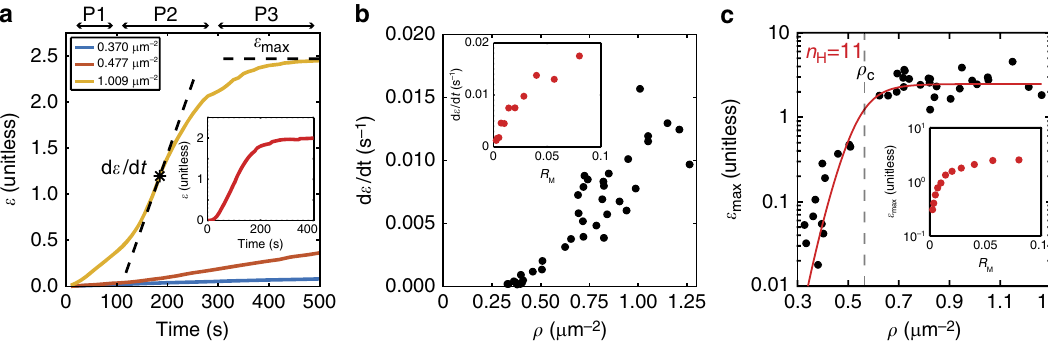
Figure 3 | Actomyosin contractility is highly cooperative. ( a ) Network strain ( e ) time course for low ( r myo ¼ 0.37 m m (cid:2) 2 ) (blue), medium ( r myo ¼ 0.48 m m (cid:2) 2 ) (red) and high ( r myo ¼ 1.01 m m (cid:2) 2 ) (orange) myosin density. Three different stages are shown: P1 ( o 100s), P2 (100–300s) and P3 ( 4 300s). The strain rate, d e /d t is taken at P2. The maximum network strain ( e max ) is taken at P3. ( a , inset) Strain at high myosin concentration in the agent-based model ( R M ¼ 0.04, the ratio of myosin concentration to actin concentration). ( b ) Contractile strain rate as a function of myosin thick filament density, r . ( b , inset) Agent-based simulation of strain rate versus R M . ( c ) Maximum contractile strain as a function of r . The red line corresponds to a fit to the Hill equation, with a hill coefficient ( n H ) of 11 (Supplementary Methods). The dashed line denotes the critical myosin density, r c ¼ 0.56 m m (cid:2) 2 , above which the F-actin networks undergo significant strain ( e max 4 1). ( c , inset) Agent-based simulation of contractile strain and R M .